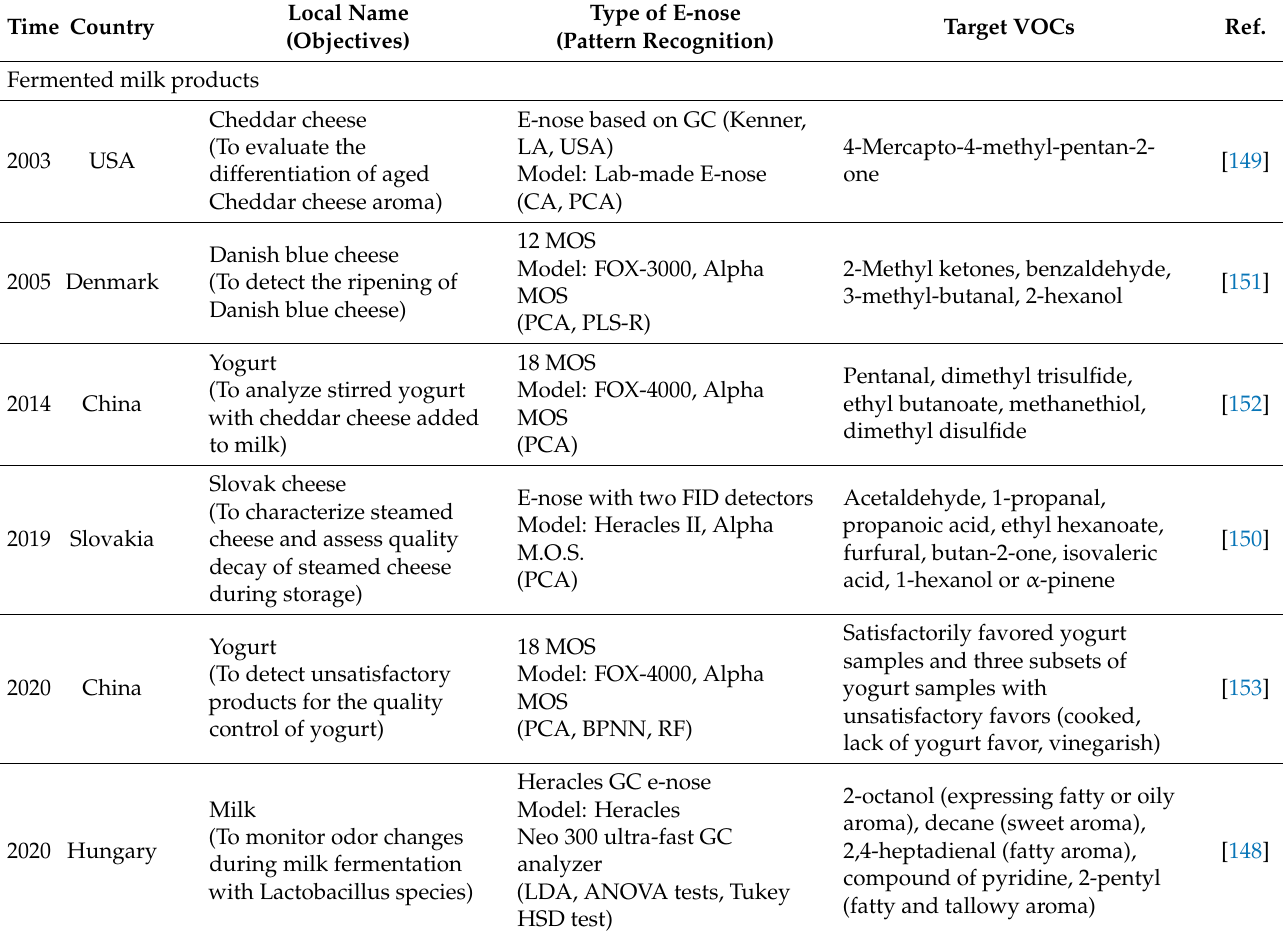
Table 2. E-noses for lactic acid